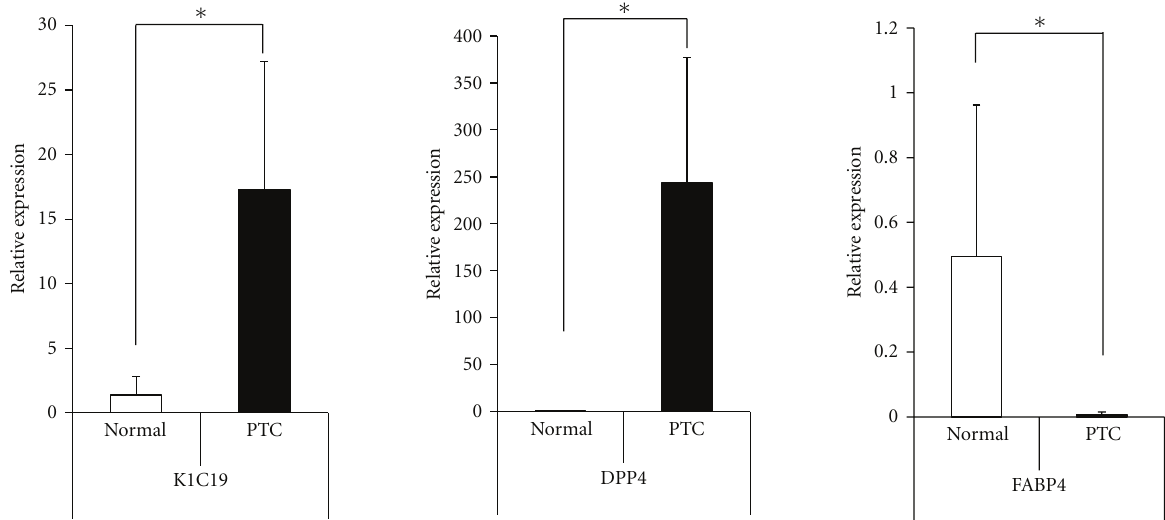
Figure 3: Gene expression of previously known markers (K1C19, DPP4, and FABP4) in normal thyroid tissue and PTC. Gene expression levels of K1C19 and DPP4 were significantly higher in PTC when compared with normal thyroid tissue. In contrast, FABP4 expression was lower (Normal: normal thyroid tissue, PTC: Papillary thyroid carcinoma, ∗ P < 0 . 05, Bar: 1 SD).